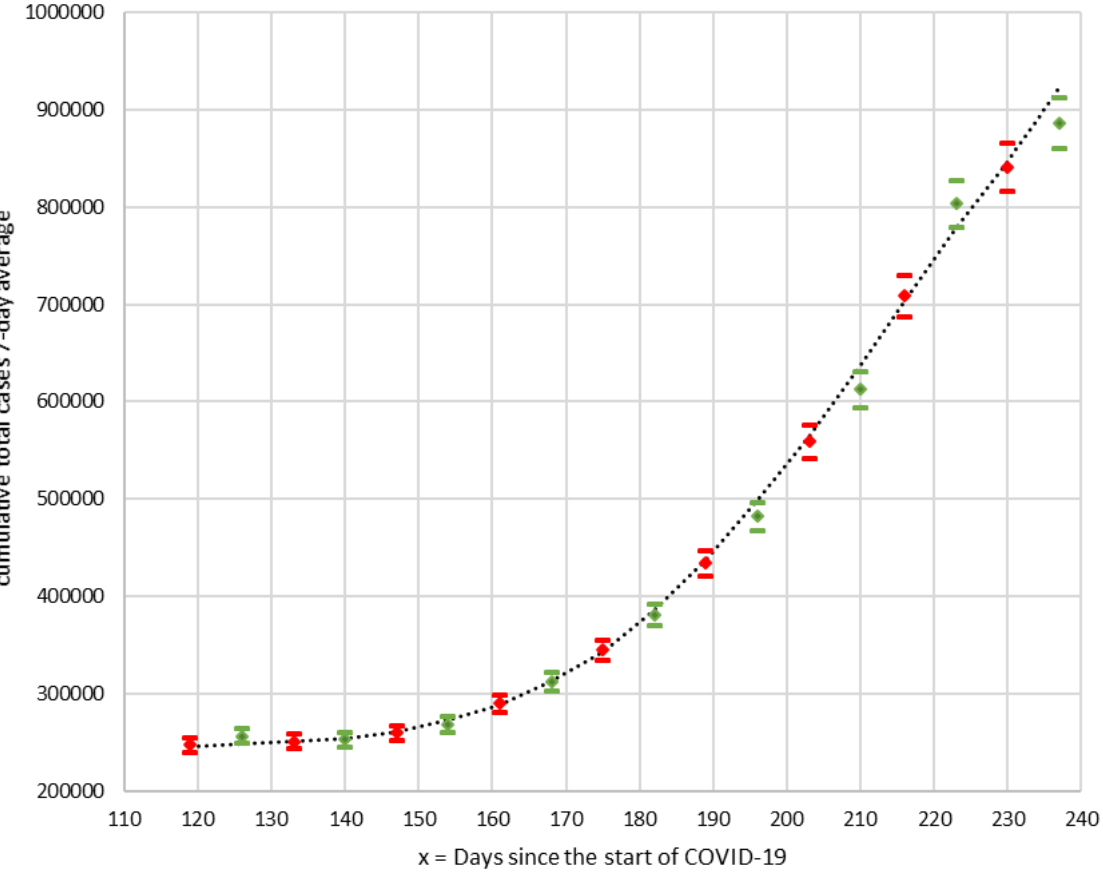
Figure 8. Favorable and unfavorable scenarios versus observed curve of the seven day average of the cumulative number of cases: y ∗ (dashed line), ˆ y ∗ 14 days (green), and ˆ y ∗ seven days